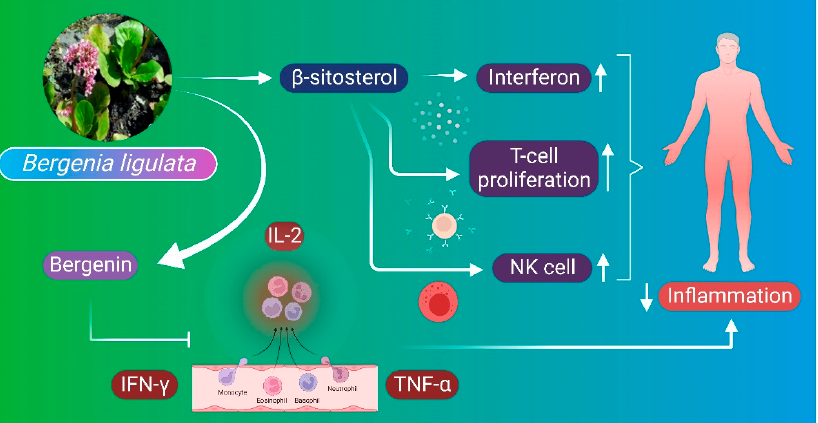
Figure 6. Anti-inflammatory mechanism of B. ligulata . Beta-sitosterol is an important constituent of B. ligulata plant extract that possesses anti-inflammatory properties. It induces the proliferation of T cells and releases interferon. Anti-inflammatory properties of the plant are attributed to the syner- gistic effect of pro-inflammatory enzyme inhibitors that are responsible for reducing the inflamma- tory response. Bergenin also inhibits the formation of proinflammatory cytokines such as interleu- kin-2 (IL-2), interferon gamma (IFN- ɣ ), and tumor necrosis-alpha (TNF- α ), all assisting in the anti- inflammatory response. NK—natural killer cell.